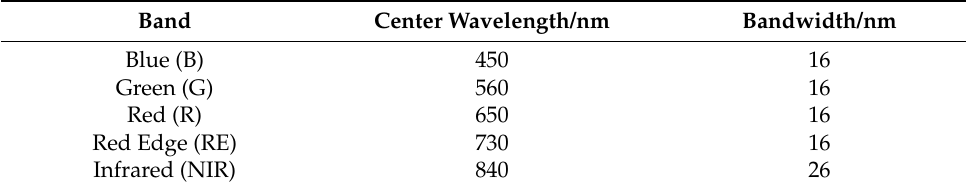
Table 3. Vegetation indices based on RGB digital number value and calculation method.